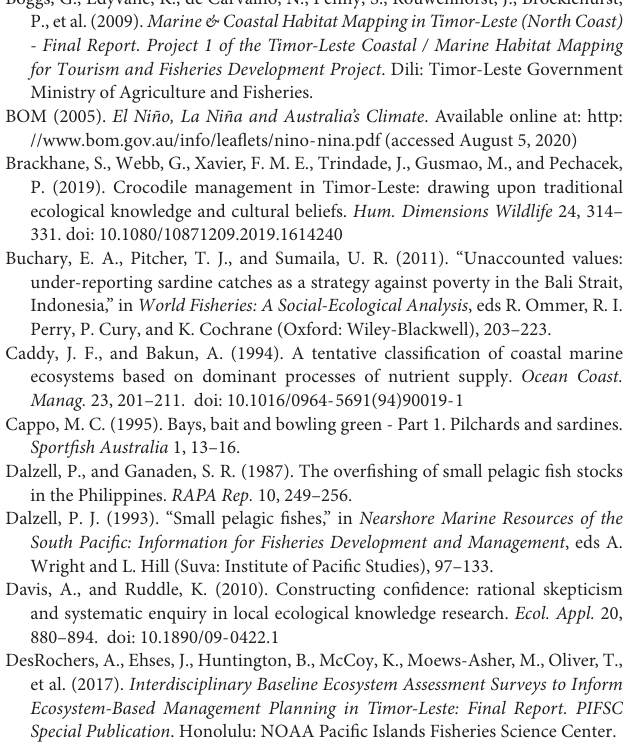
Supplementary Figure 1.1 | Photographs of sardines used in local knowledge and naming discussions. Supplementary Table 1.1 | Details of research activities carried out at each location. Supplementary Table 1.2 | Local naming corresponding to reference photos of sardine species-groups. Supplementary Table 1.3 | Discussions, conversations, and observations at Loes fishery study site. Supplementary Table 1.4 | Discussions, conversations, and observations at Comoro fishery study site. Supplementary Table 1.5 | Discussions, conversations, and observations at other locations around